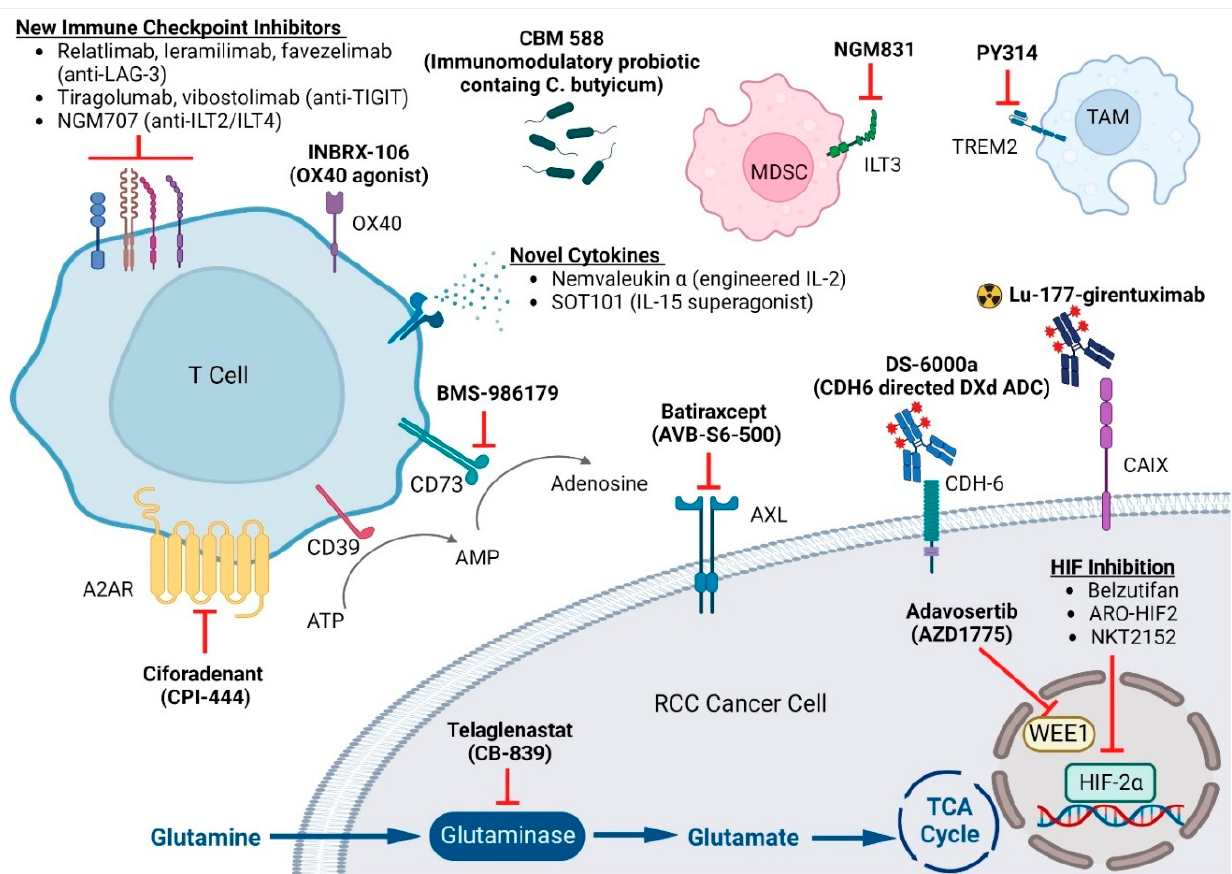
Figure 1. Emerging Targets in Clear Cell Renal Cell Carcinoma. This figure is created with BioRender.com. LAG-3: Lymphocyte-activation gene 3; TIGIT: T cell immunoreceptor with Ig and ITIM domains; ILT: Ig-like transcript; MDSC: Myeloid-derived suppressor cell; TAM: tumor-associated macrophage; A2AR: adenosine 2A receptors; ATP: adenosine triphosphate; AMP: adenosine monophosphate; CDH6: human cadherin 6; CAIX: carbonic anhydrase IX; TCA: tricarboxylic acid; HIF: hypoxia-inducible factor.